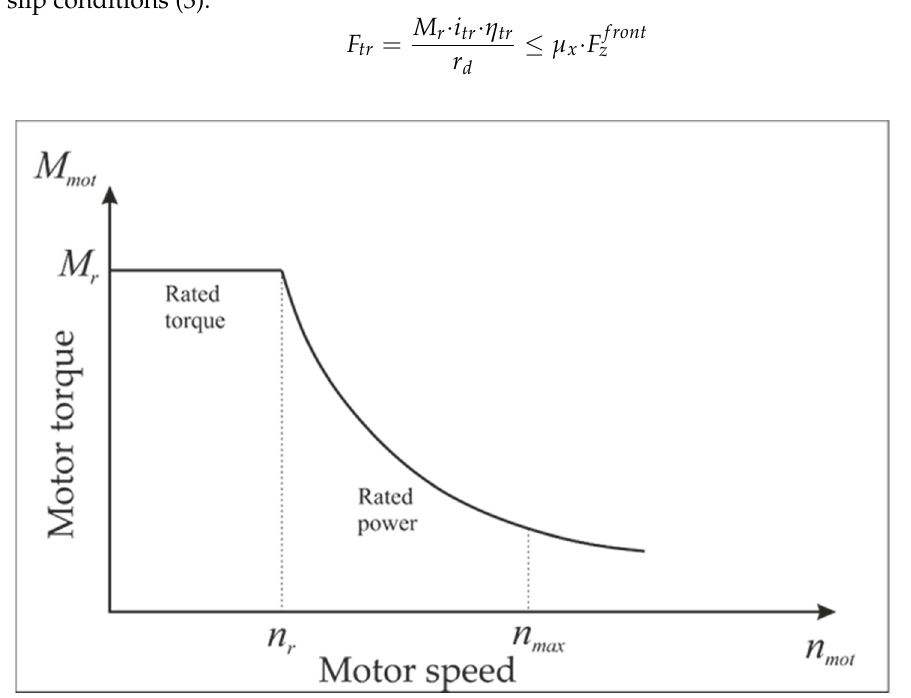
Figure 2. Motor output torque curve.